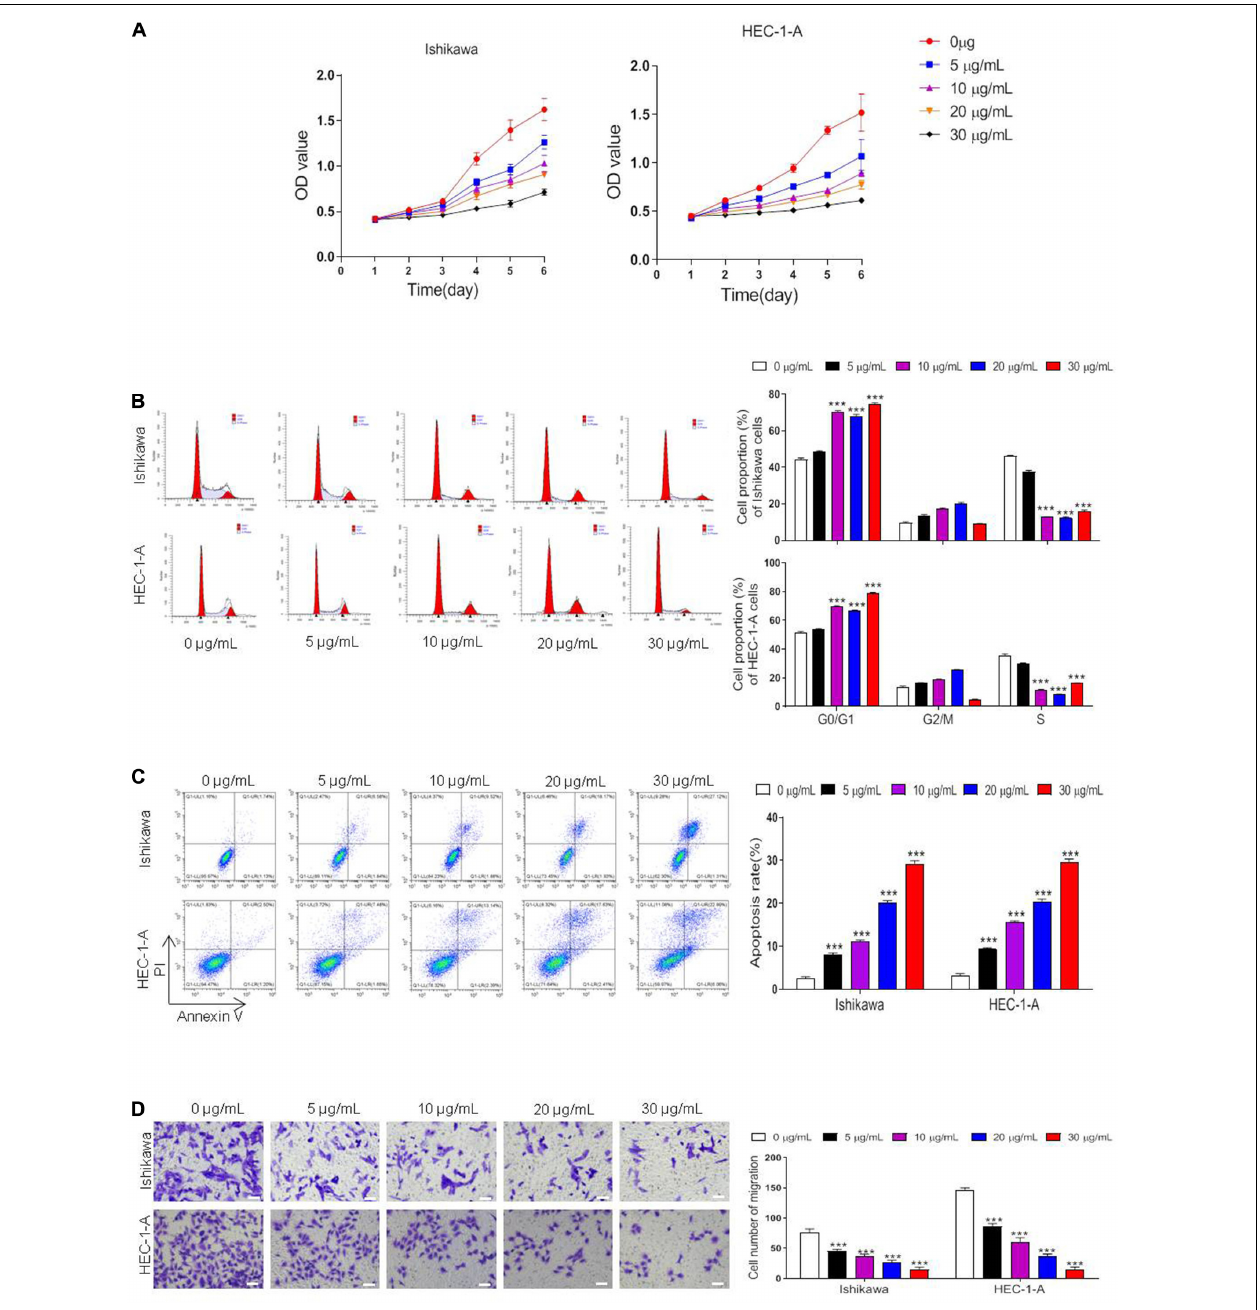
FIGURE 2 | Artesunate (ART) inhibited the proliferation of Ishikawa and HEC-1-A cells. Cells were treated with ART at different concentrations (0–30 µ g/mL) for 1–6 days. (A) Cell viability was measured with the CCK-8 assay. (B–D) The cell cycle analysis, apoptosis, and migration assays were performed in these cells after different treatments. Bar = 20 µ m. The data were showed as the mean ± SD, *** p < 0.001 vs. the 0 µ g/mL of ART-treated group.